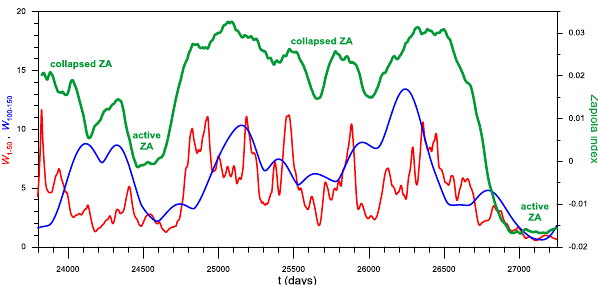
Fig. 15. Green line: Zapiola index. Red and blue lines: integrated wavelet amplitudes W 1 , 50 and W 100 , 150 ,